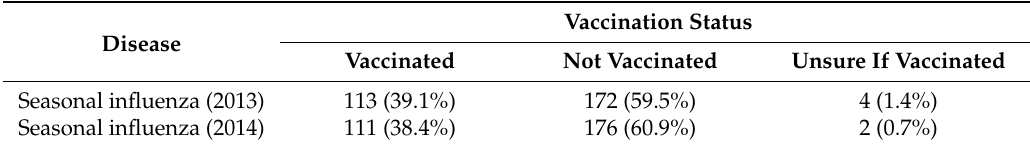
Table 2. Rates of self-reported seasonal influenza vaccination among medical students.